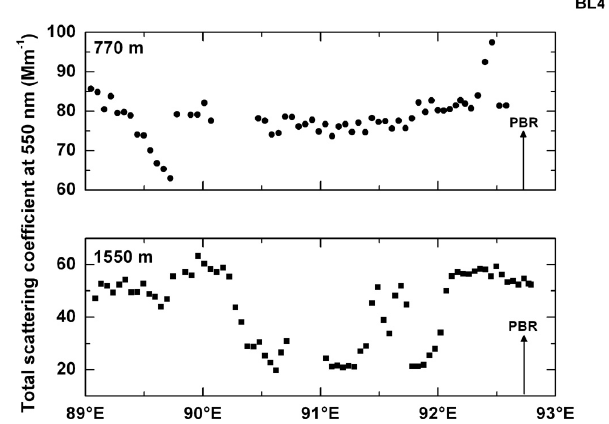
Fig. 10. Longitudinal variation of σ tsc at 770 (upper panel) and 1550m (lower panel) altitude off-PBR during BL4 over 11.65 ◦ N latitude. The arrows in both the panels represent the longitude of PBR airport.